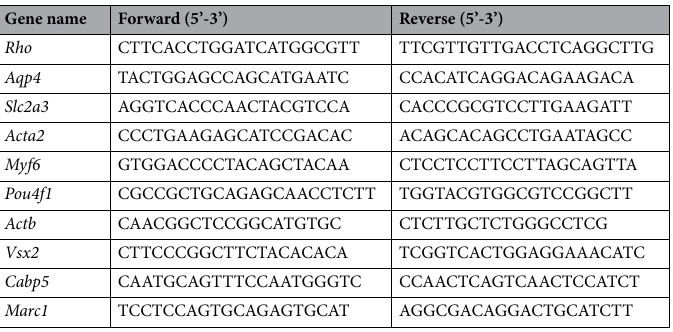
Table 3. Primers used for real-time